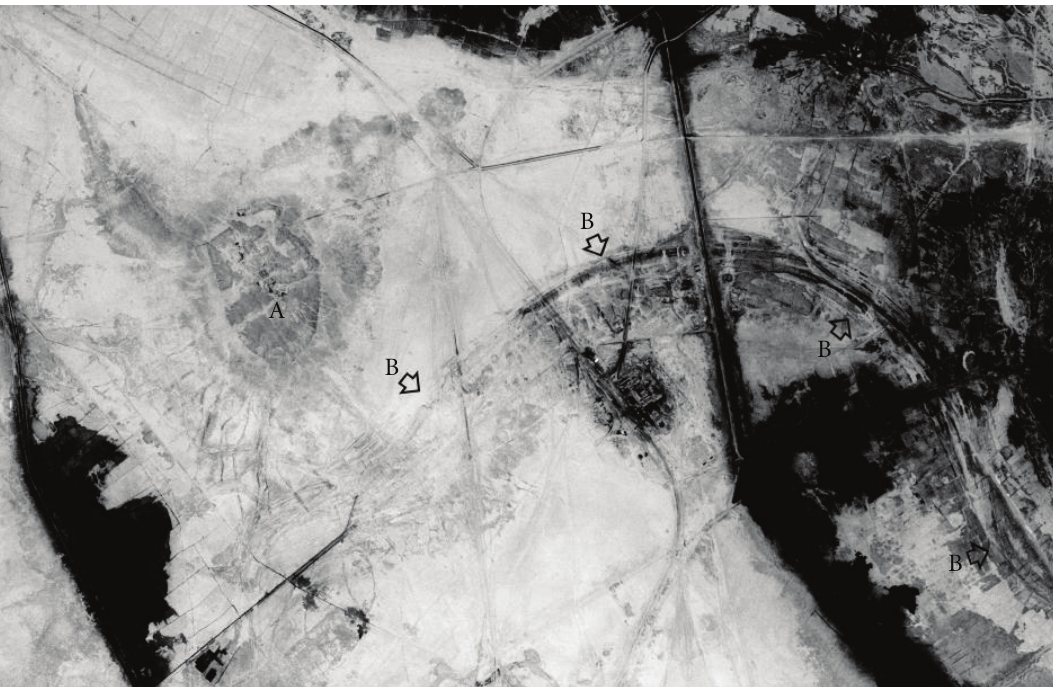
Figure 12: Ur (A) and the surrounding territory in a Corona KH-4B photo of May 1968: a lot of traces (B) of the paleoriver bed of the Euphrates are visible.